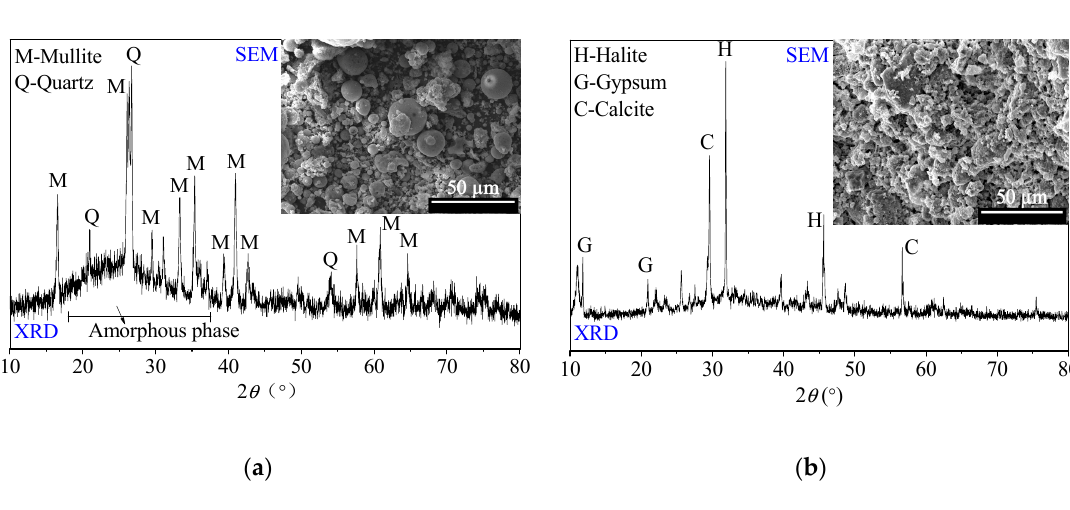
Figure 1. Scanning electron microscopy (SEM) photos and X-ray diffraction (XRD) patterns of ( a ) low-calcium fly ash (FFA) and ( b ) soda residue (SR) [24].